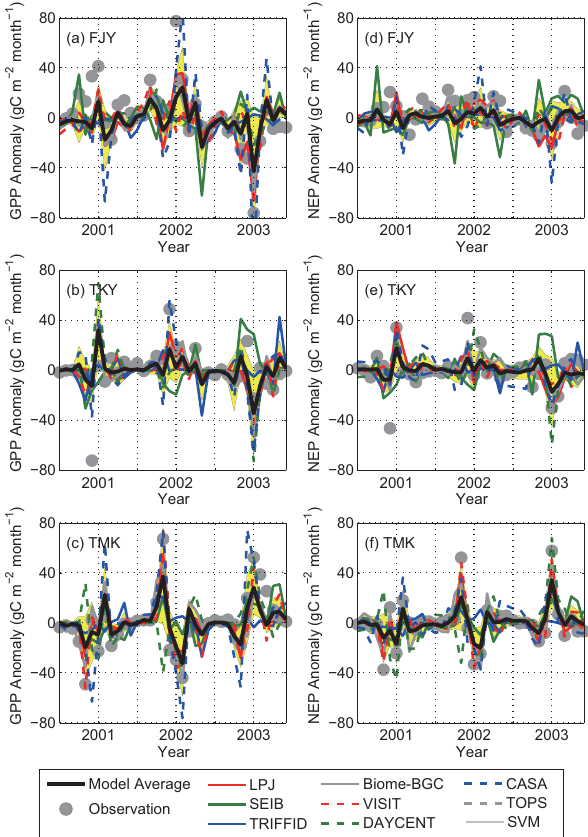
Fig. 6. Interannual variations in (a)–(c) GPP and (d)–(f) NEP anomalies from mean monthly variations based on ecosystem mod- els, multi-model averages, and observations. Colors are the same as in Fig. 2. Results from modified models are